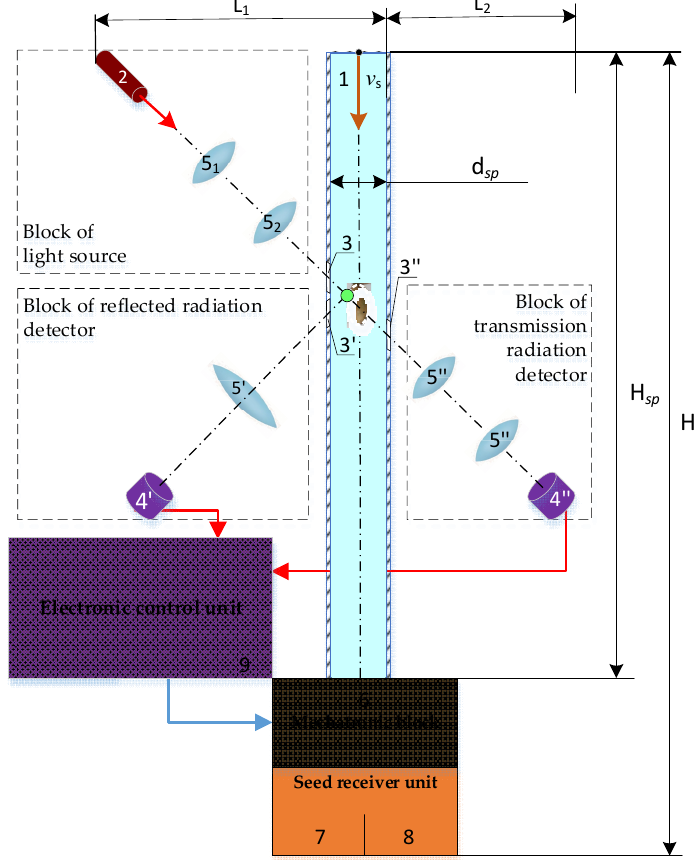
Figure 2. Structural and functional diagram of the diagnostic system for modeling the process of detecting a single seed. 1—seed pipe; 2—light source; 3, 3′ and 3″—input recording window and windows for registering radiation, respectively; 4′ and 4″—receivers for detecting reflected and transmission radiation, accordingly; 5 1 , 5 2 , 5′, and 5″—focusing lenses; 6—flap; 7—viable seeds receiver; 8—non-viable seeds receiver; 9—electronic control unit.